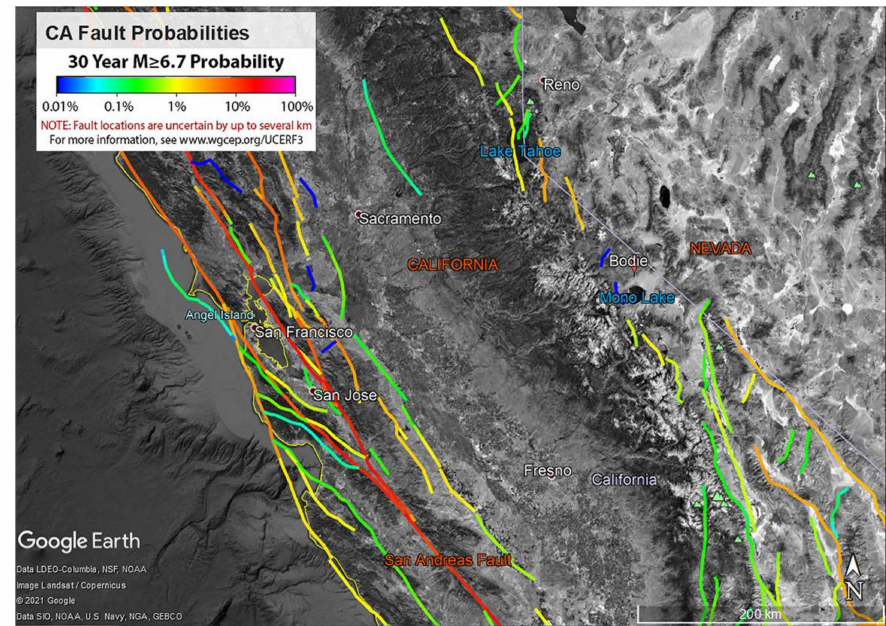
Figure 6. Map showing Bodie’s proximity to several faults’ locations in California and their probabil- ity of being involved in seismic activities of magnitude ≥ 6.7 in the next 30 years. Generated from data made available by the Working Group on California Earthquake Probabilities and Google Earth Pro v.7.3.4.8248 (22 February 2014). Bodie, California. 38 ◦ 12 (cid:48) 45.41 (cid:48)(cid:48) N, 119 ◦ 00 (cid:48) 48.25 (cid:48)(cid:48) W, Eye alt 10,378 feet. Data LDEO-Columbia, NSF, NOAA, SIO, U.S. Navy, NGA, GEBCO. Image Landsat/Copernicus. Google 2021. http://www.earth.google.com [accessed on 22 July 2021]. Map by N.